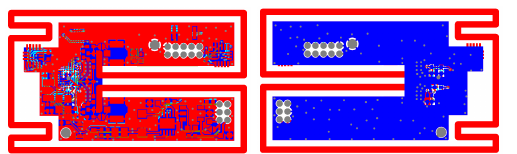
Figure 2. SPW-1: Top view (left) and bottom view (right) of the circuit board.